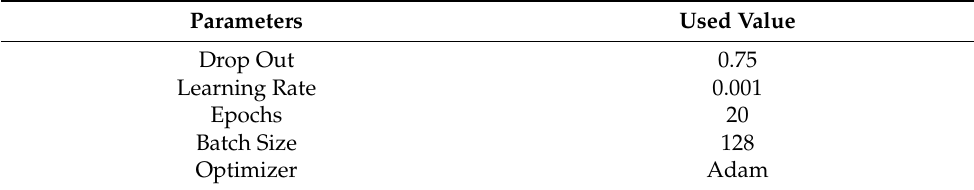
Table 2. Parameters Used in the Exception